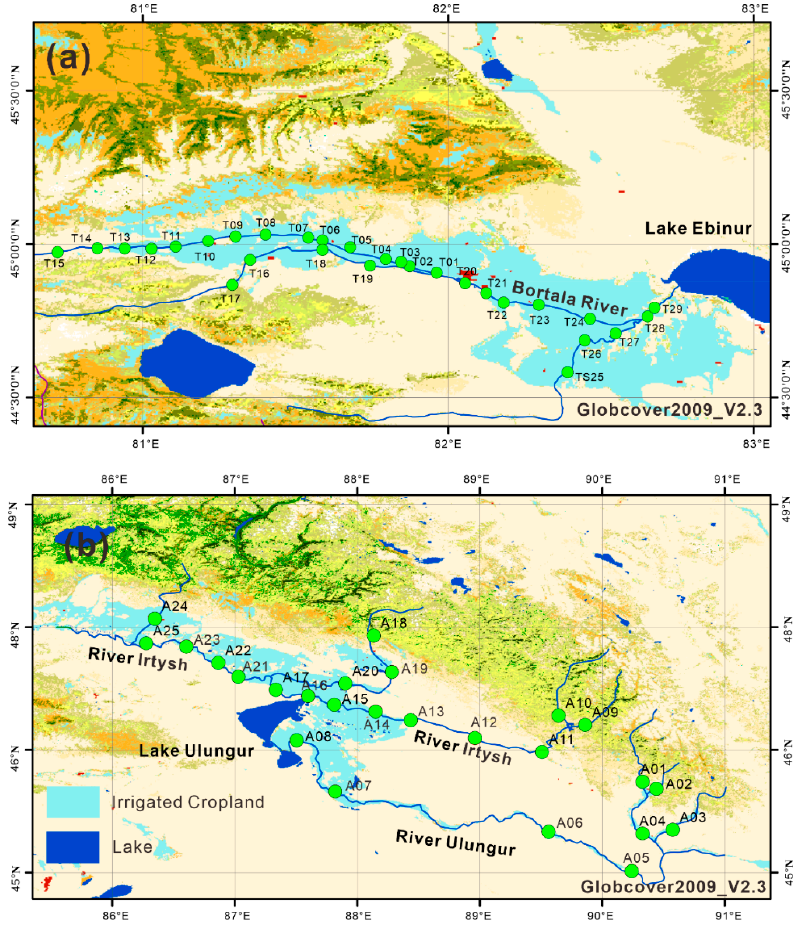
Figure 2. The water-sample locations in the regions of the Tianshan ( a ) and Altay ( b ) Mts. The globe land cover map was based on GlobCover2009 from European Space Agency GlobCover Portal (http://due.esrin.esa.int/page_globcover.php, accessed on 20 August 2021).